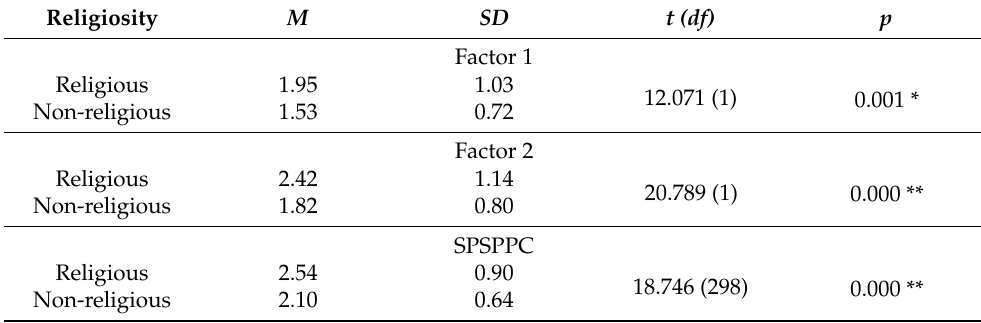
Table 4. Sexual prejudice levels by religiosity (religious or